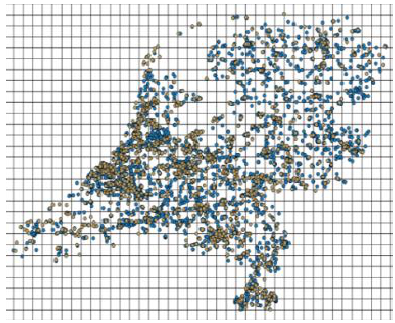
Figure 4. Fuels stations (blue) and chargers point (brown) distribution on grid.